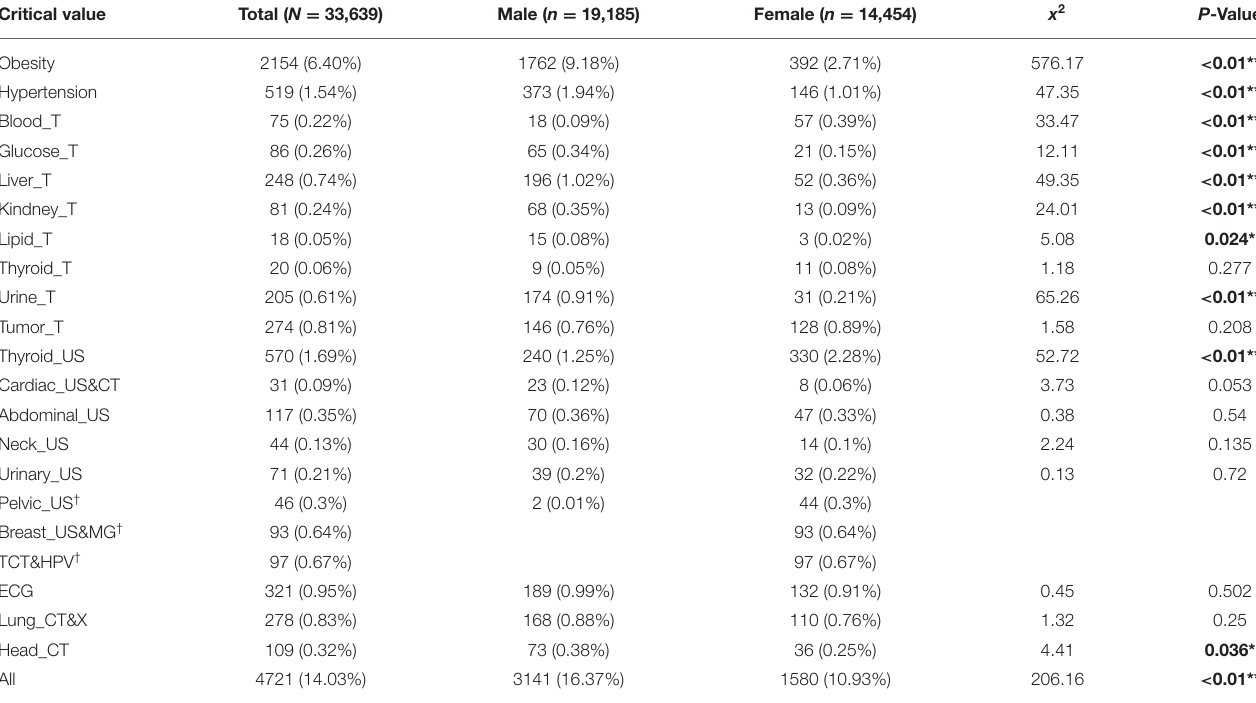
TABLE 5 | The prevalence and significance analysis of critical values in health checkup.